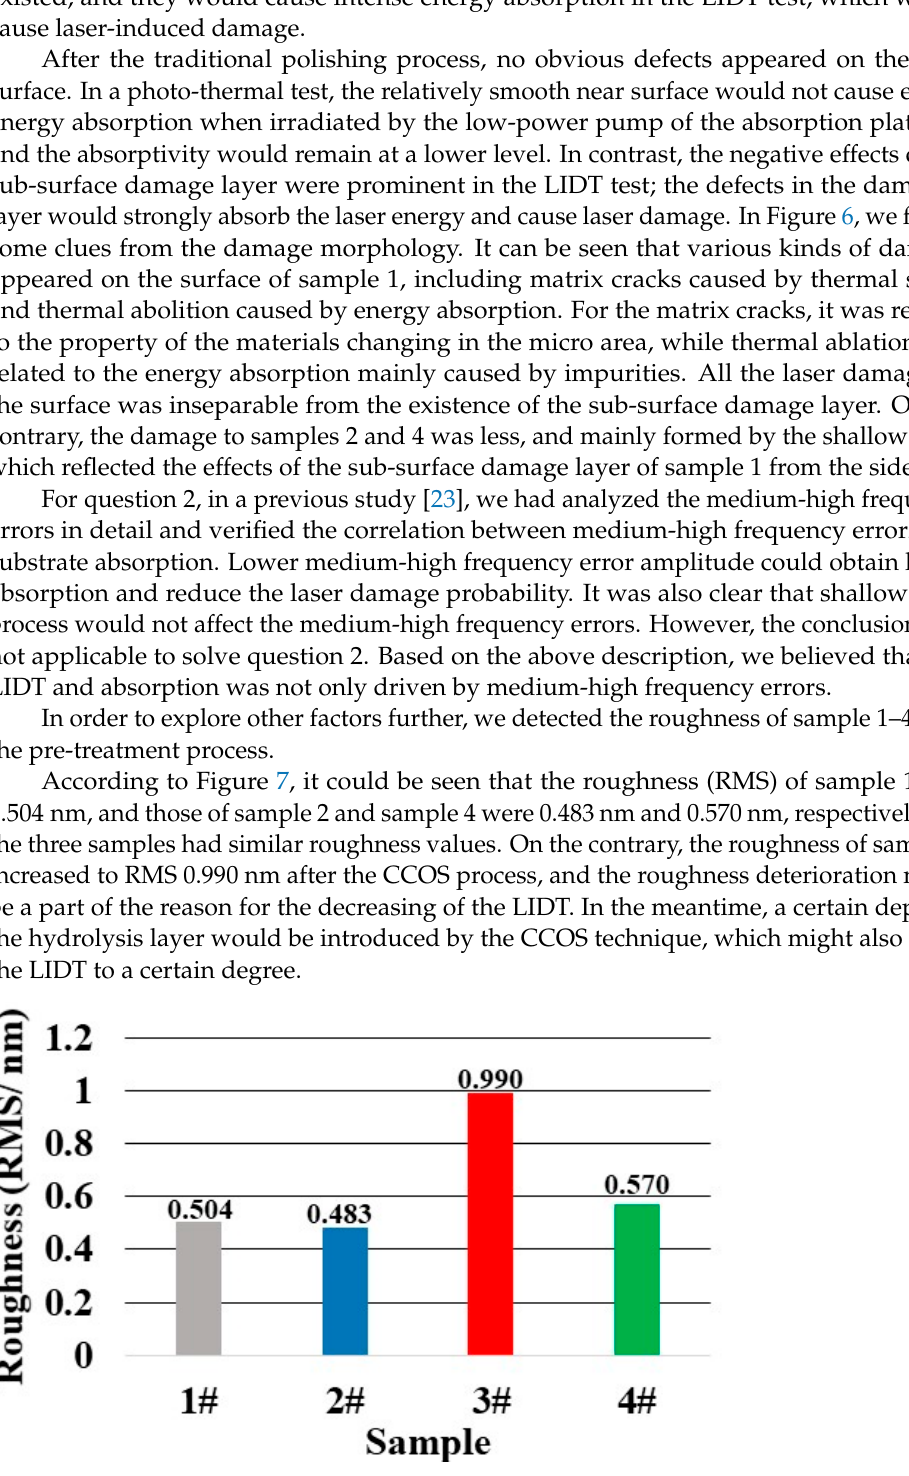
Figure 7. Roughness results of sample 1 – 4 after pre-treatment process.